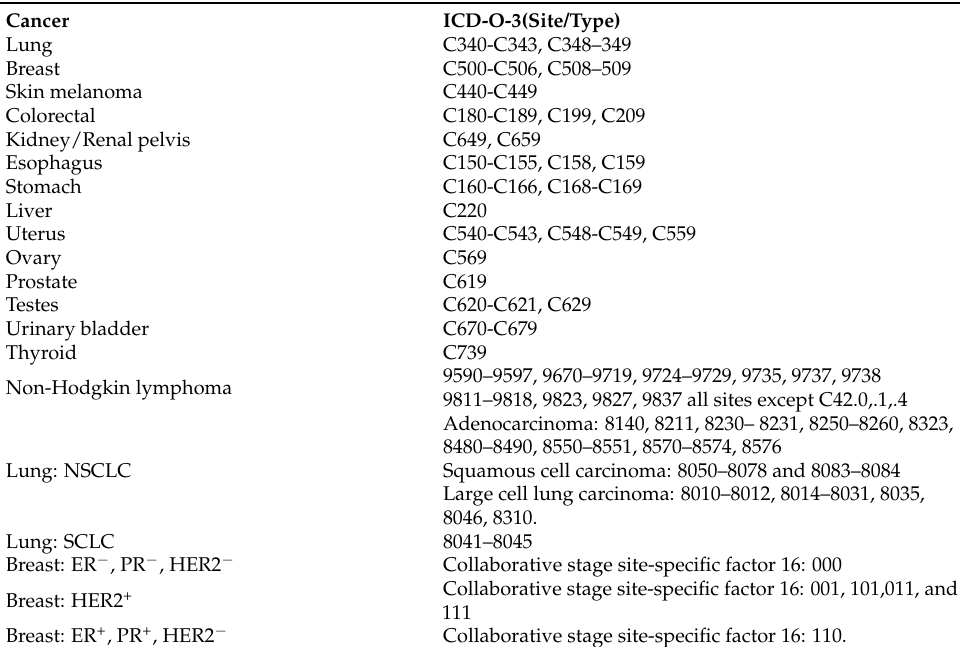
Table A1. Cancer Definitions by SEER ICD-O-3